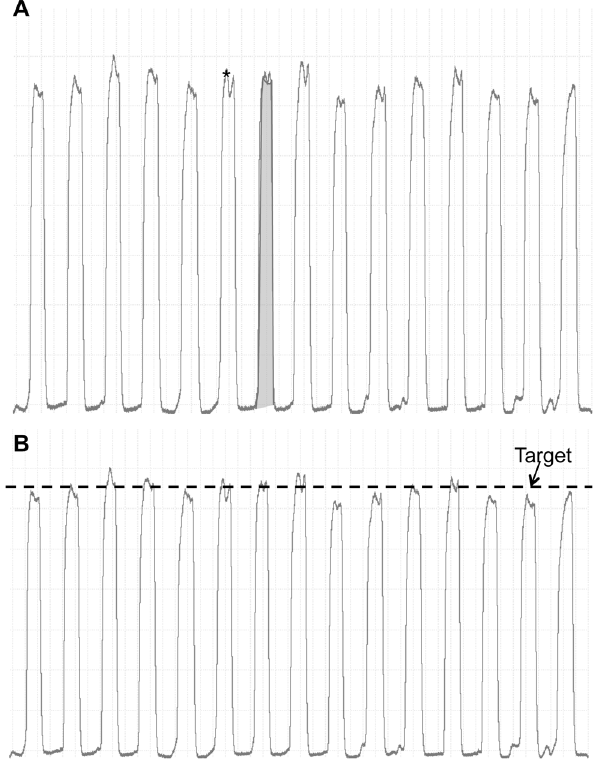
Figure 2. Force tracings from a representative subject. Panel A: Raw force trace depicting the data points used for calculation of the peak force (single *) and force impulse (shaded grey area) Panel B: Raw force trace during constant intensity handgrip exercise at target force of 10% . fCF peak force . Arrow indicates first of three consecutive contrac- tions where target force was not achieved, and represents the time at which exhaustion occurred.